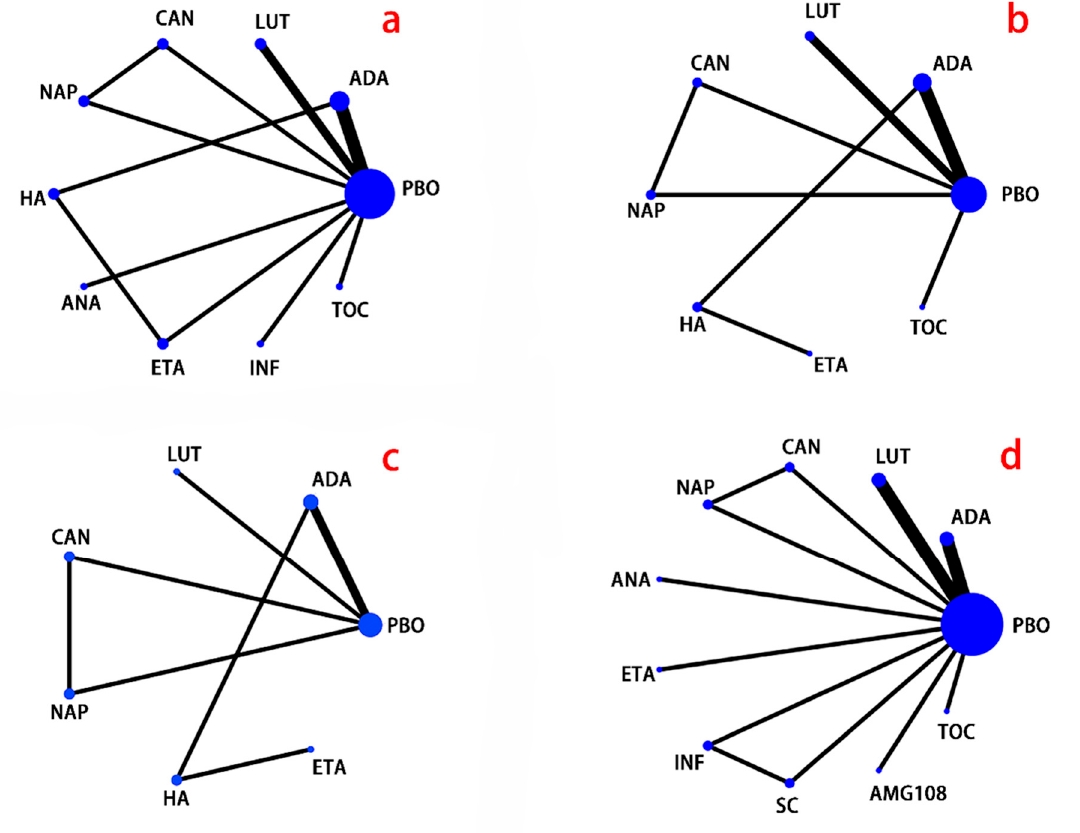
Figure 2. Network plot. ( a ), pain; ( b ), physical function; ( c ), stiffness; ( d ), adverse events; PBO, placebo; ADA, adalimumab; LUT, lutikizumab (ABT981); CAN, canakinumab; NAP, naproxen; HA, hyaluronic acid; ANA, anakinra; ETA, etanercept; INF, infliximab; SC, standard care; TOC, tocilizumab. The size of the circle represents the number of participants, and the thickness of the line represents the number of studies.